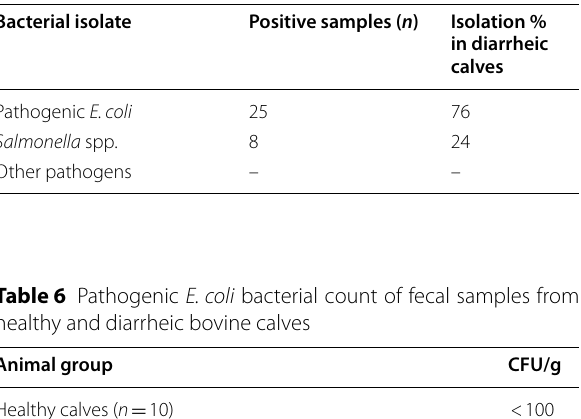
Table 5 Bacteriological examination of fecal samples from 33 diarrheic bovine calves Bacterial isolate